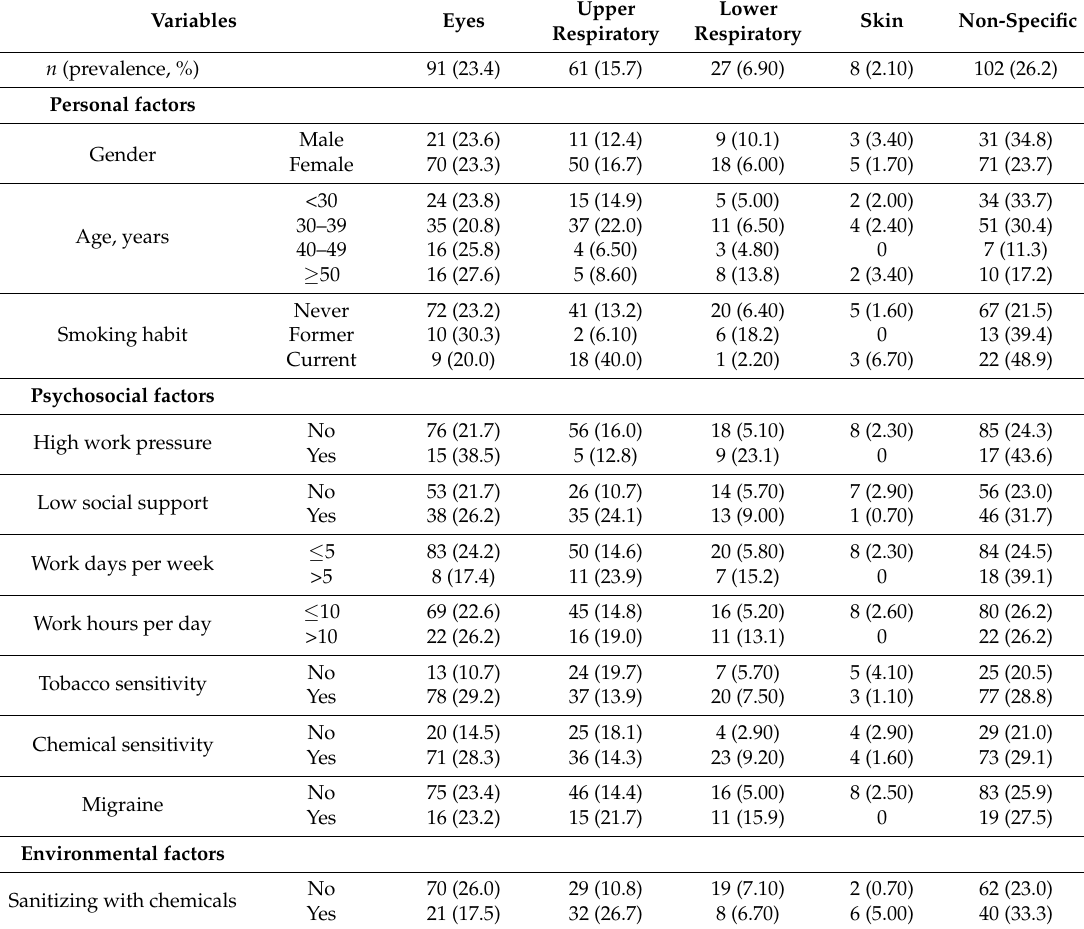
Distributions of sick building syndrome symptoms by personal, psychosocial, and environmental factors, for eyes, upper respiratory system, lower respiratory system, skin, and non-specific symptoms ( n =